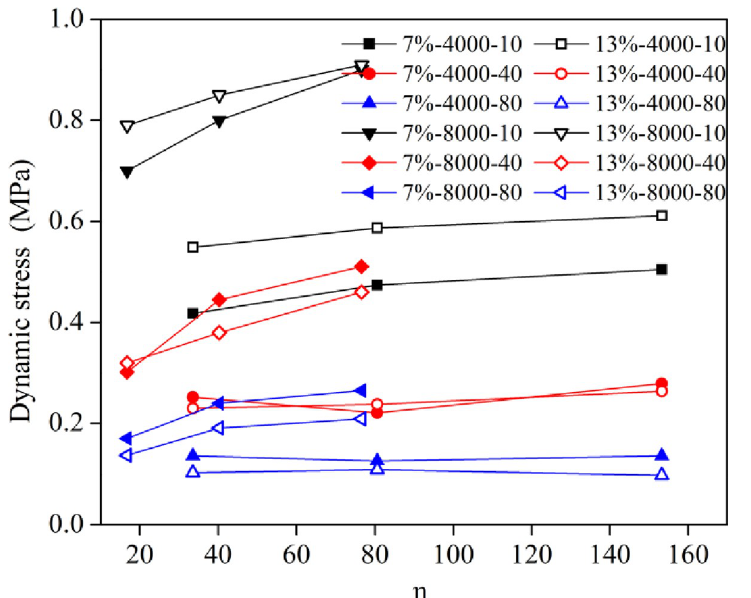
Fig 13. Variation curve of the dynamic stress at different